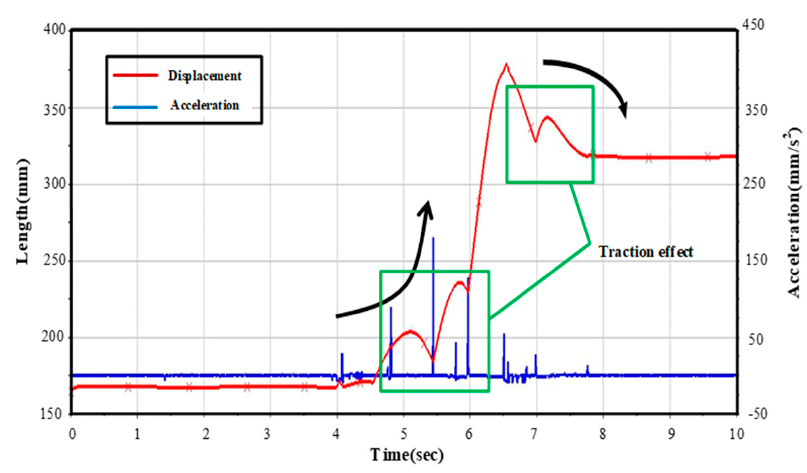
Figure 22. Simulation results of robot vertical terrain displacement and acceleration variation.